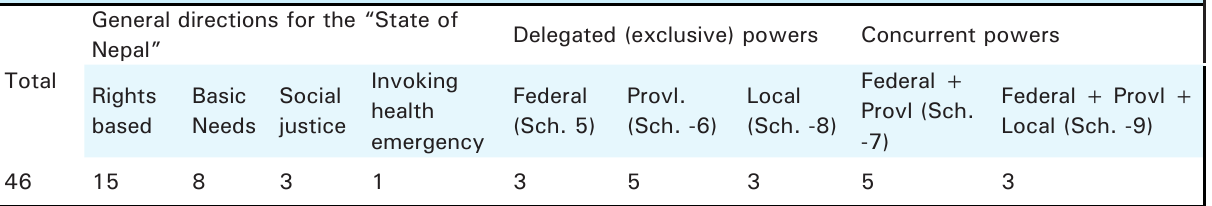
Table 1. Constitutional provisions related to